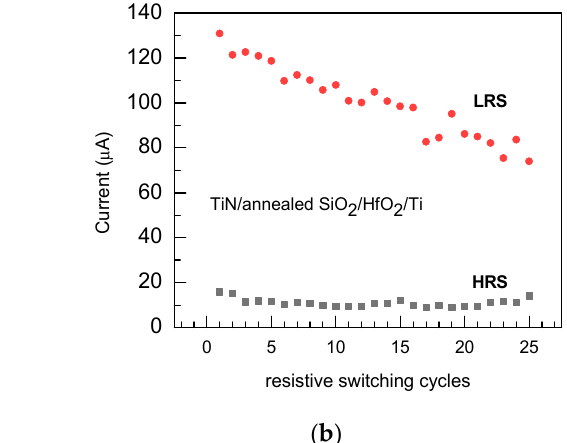
ble 1) containing as-deposited SiO 2 and HfO 2 dielectric films. The diameter of the top titanium elec-